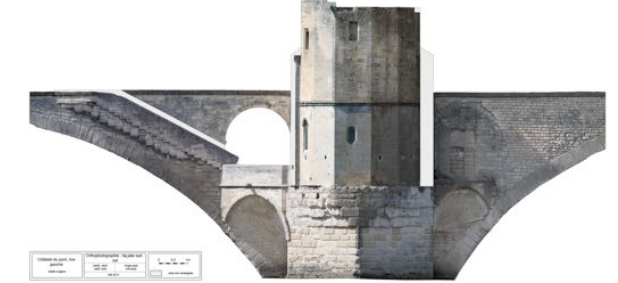
Figure 3. Coloured point clouds of Tour Philippe le Bel created by image matching with Apero/MicMac